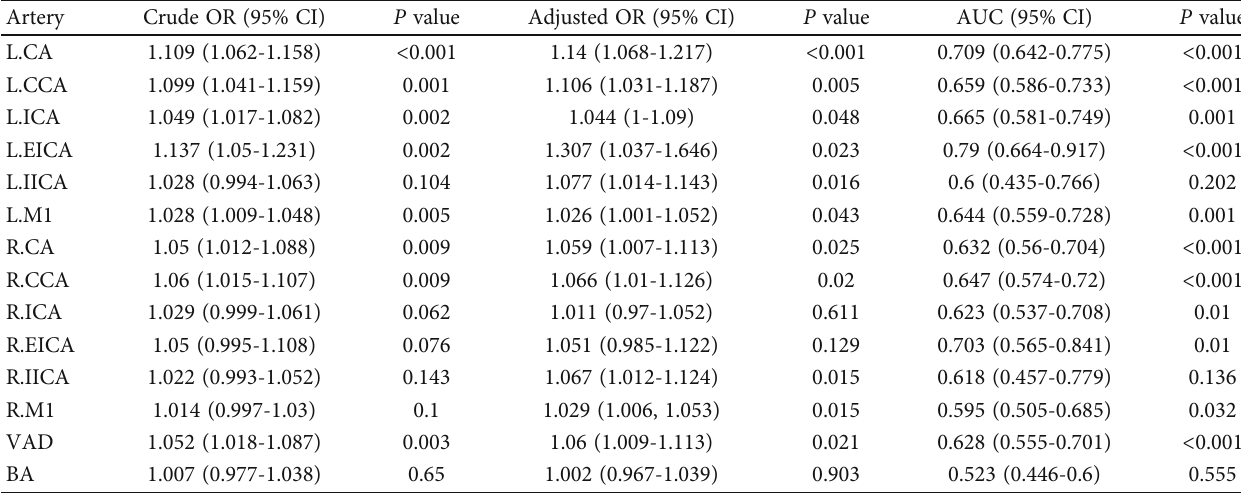
Table 1: Correlation analysis of each arterial tortuosity with AIS.